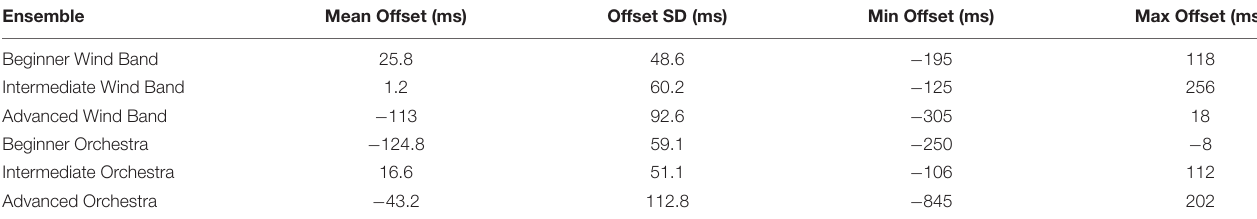
TABLE 3 | Mean offset values by ensemble.